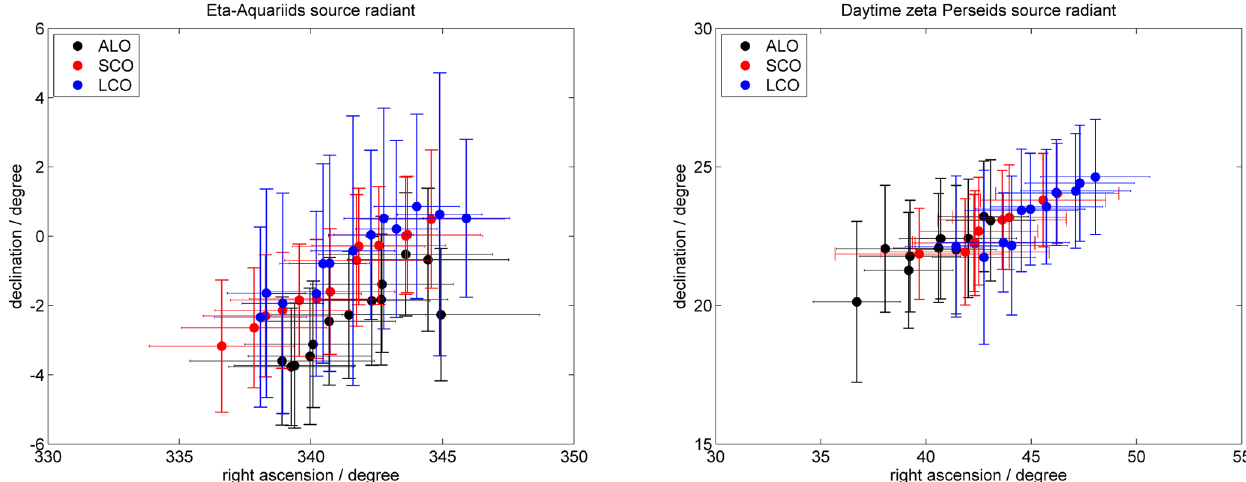
Figure B1. Scatter plots of meteor source radiant tracking for the eta Aquariids and daytime zeta Perseids.